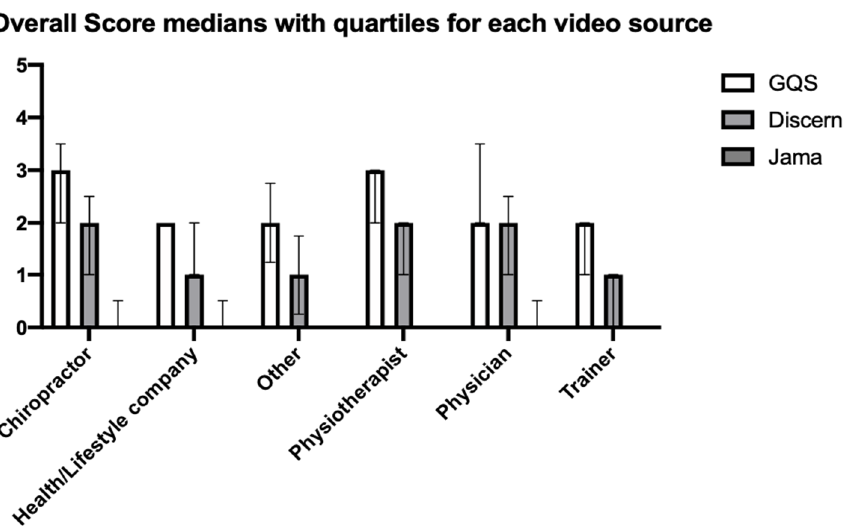
Figure 1. Median Score for GQS, Discern and Jama benchmarks by video source with upper and lower quartiles. Mean Ranks for GQS and Discern Score were significantly higher in Chiropractors and Physiotherapists when compared to Trainer videos.